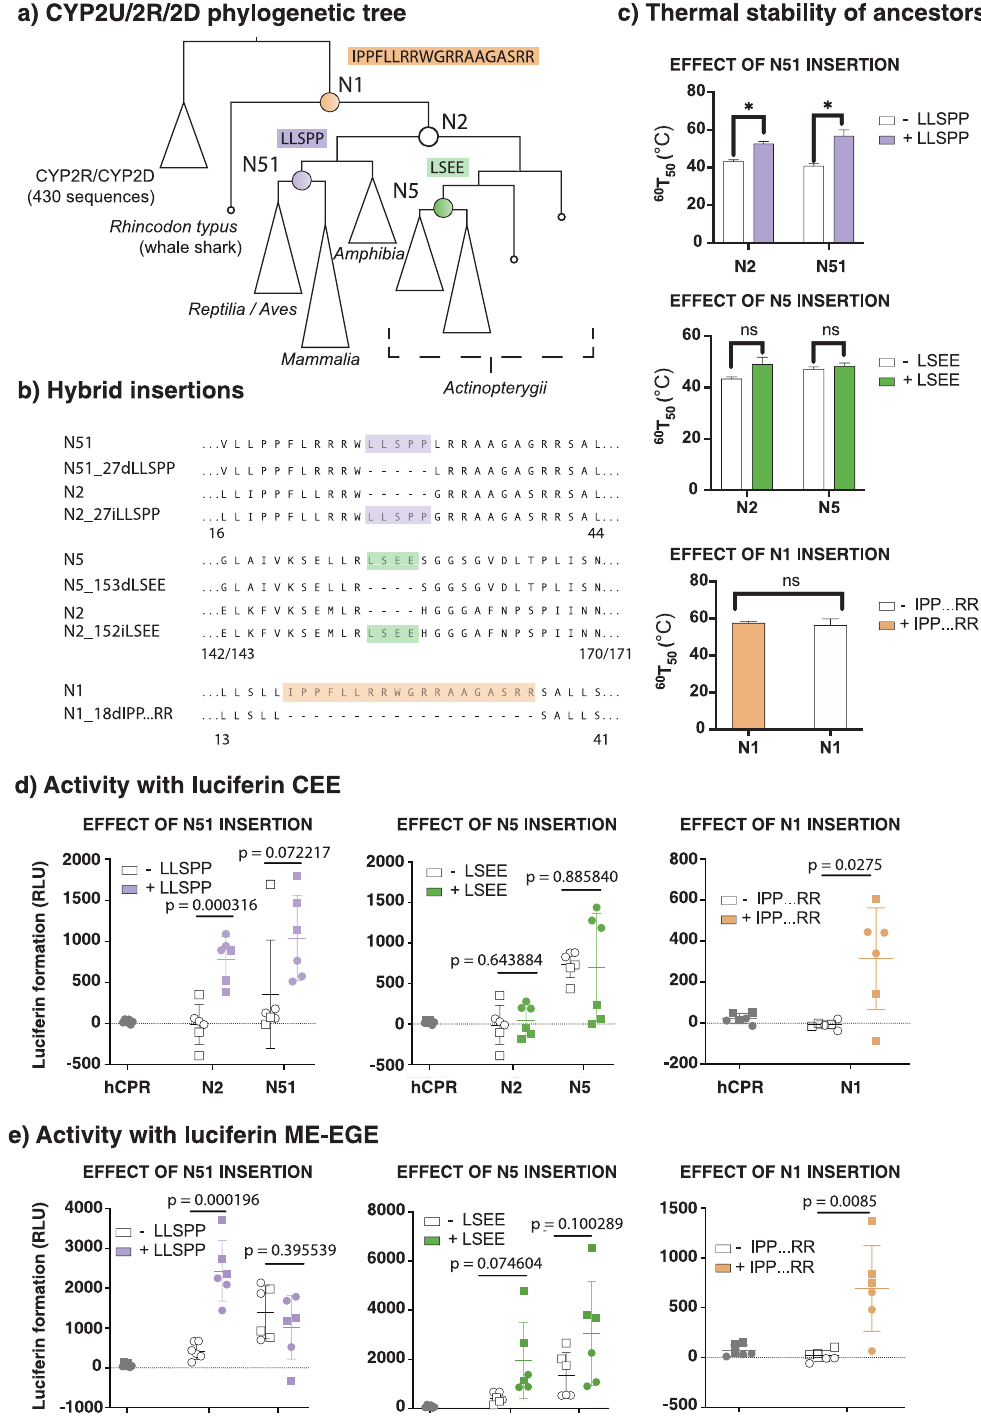
Fig 3. A, Phylogenetic tree showing positions of CYP2U/CYP2R/CYP2D ancestors chosen for synthesis and evaluation. Coloured boxes indicate the content that was removed from correspondingly coloured ancestral nodes (N51, N5, and N1) and, in the case of the N51 and N5 insertions, preemptively inserted into N2. B , Amino acid sequences surrounding and including the insertion or deletion of the content at each ancestor. Numbers under sequences indicate the position numbers of the start and end columns represented in the alignment. C , Thermal stability assays for each ancestor with and without inserted content. Data are means +/- SEM, N = 2, ns indicates a not significant result. D, E , Activity